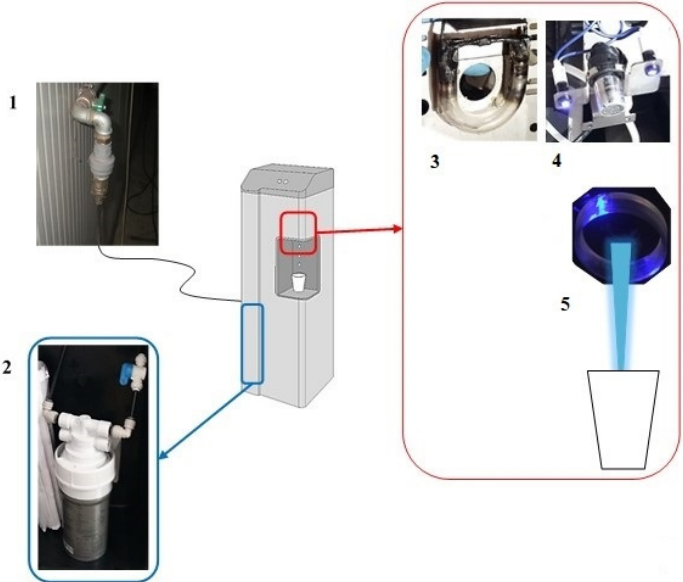
Figure 1. Schematic representation of Microfiltered Water Dispensers (MWDs) from our previous study (Girolamini et al. 2019): 1: Input from municipal water, 2: Activated carbon filter, 3: UV Lamp at water supply point, 4: UV lamp, without glass, and water supply point (output), 5: Water supply nozzle